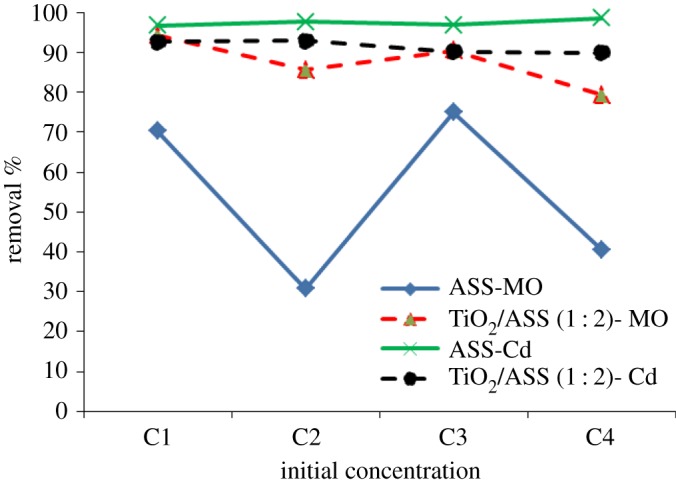
Effect of MO and Cd2
+ initial concentration on MO and Cd2+ removal efficiency by ASS or TiO2/ASS (1 : 2).